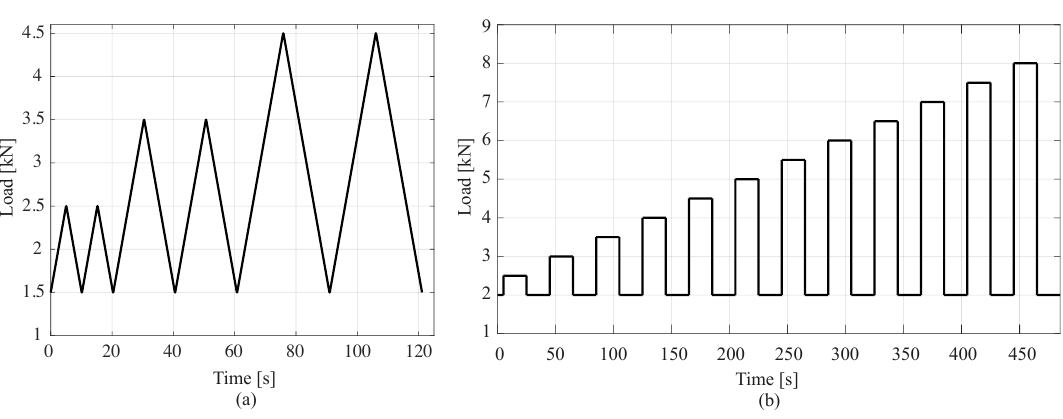
Figure 4. Loading histories for the electromechanical tests. ( a ) Cyclical load history used for cubic samples; and ( b ) step load history used for the plate